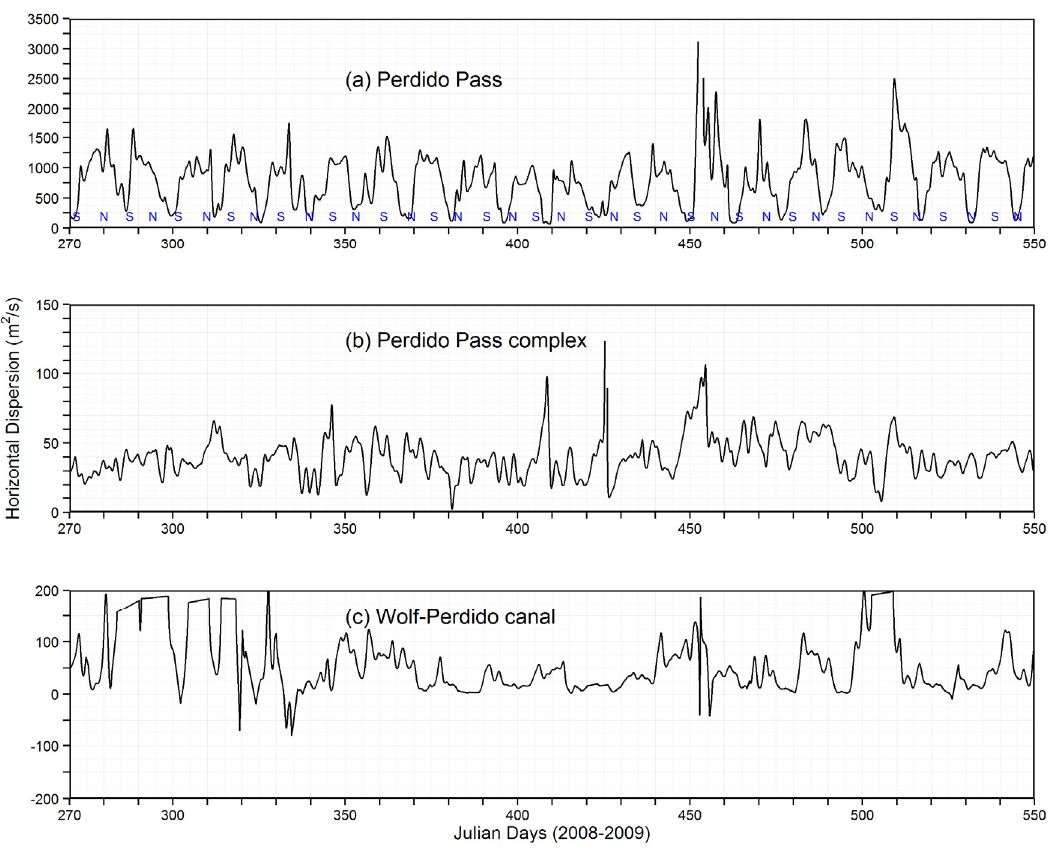
Figure 7. Horizontal dispersion ( K x ) at three cross sections (Figure 1): ( a ) Perdido Pass; ( b ) Perdido Pass complex; and ( c ) Wolf-Perdido canal. The “S” and “N” in the top panel stand for spring and neap